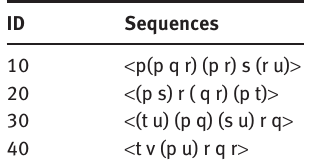
Table 1: DNA Sequence Database.